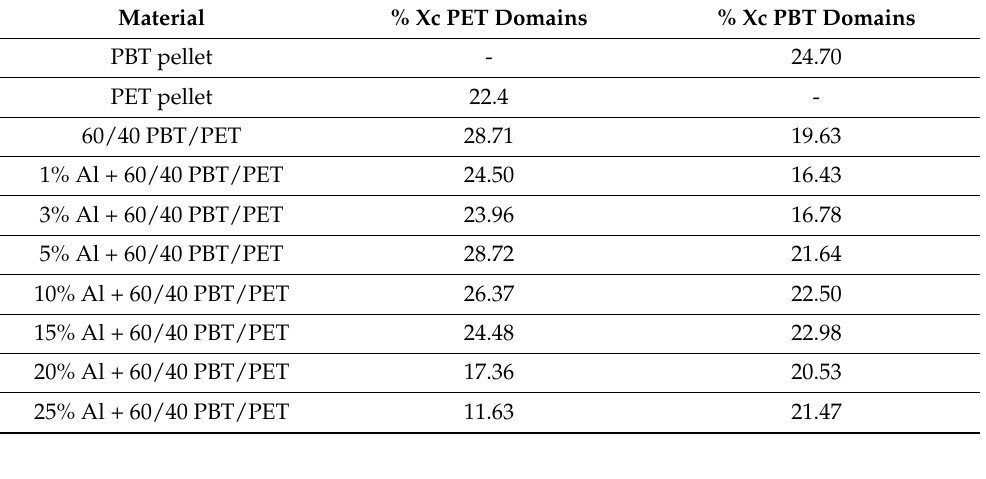
Table 2. Xc is the % crystallinity estimated from DSC of the 60/40 PBT/PET blend and aluminium- filled versions.